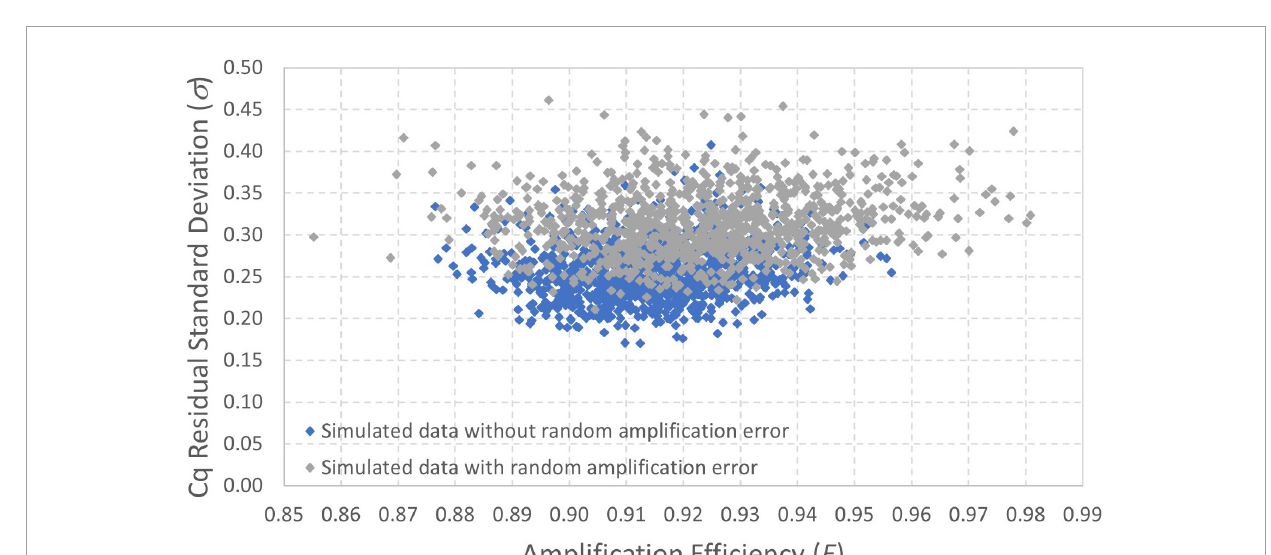
FIGURE6 Scatterplot of posterior distributions quantifying uncertainty in amplification efficiency and Cq residual standard deviation estimated from datasets simulated with and without random amplification error ( Figures 5A,B , respectively). The data were simulated with E = 0 . 9 and σ = 0 .